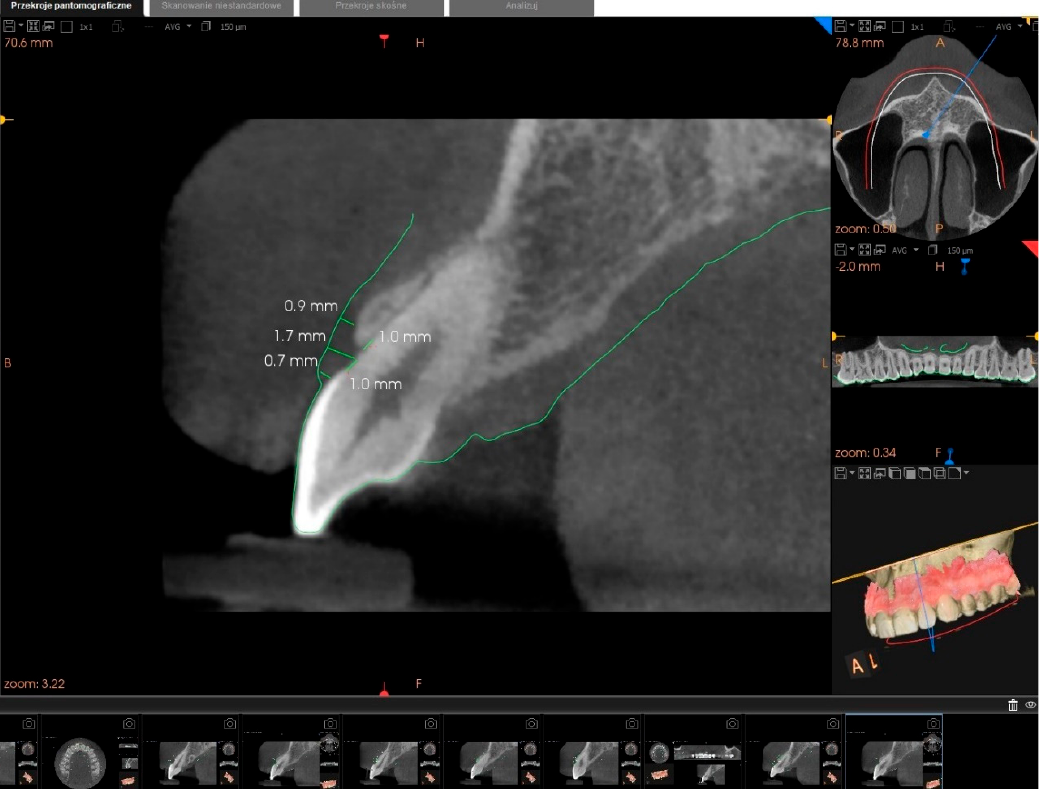
Figure 3. Cone-beam computed tomography, intraoral scanning by computer-aided design technol- ogy along with prosthetic-driven implant planning software for FGT, SGT, and CGT measurement.